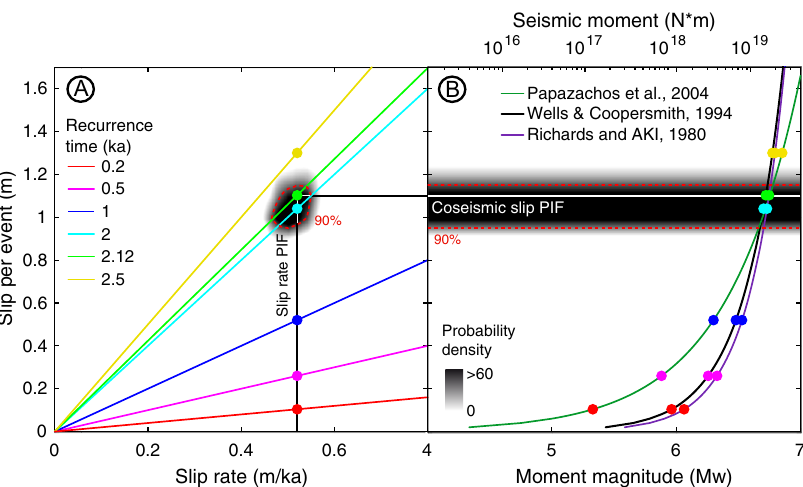
Fig. 5 Recurrence time for earthquakes on the PIF. A Recurrence times estimated for different values of coseismic slip values and long-term slip rates, assuming that PIF slip occurs only during megathrust earthquakes. B Equivalent seismic moment for each recurrence time in A , indicated by colour-coded points. Lines denote different empirical relationships (see references in text). The black-to-grey areas in A , B represent the probability-density of the PIF slip. The dashed red lines in A , B show the 90% con fi dence interval. The black line in A and white line ( B ) show the best- fi t slip per event and slip rate,